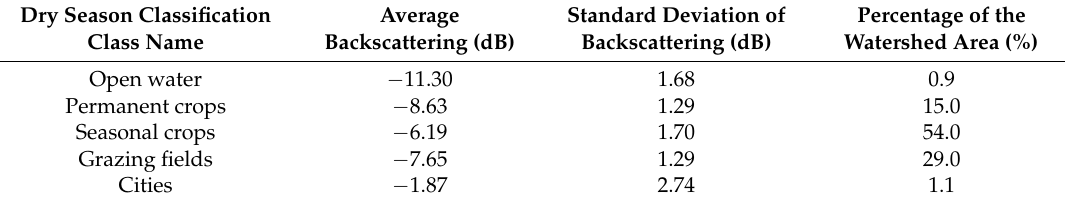
Table 2. Results of the k-nearest neighbors supervised classification performed on ENVISAT ASAR GM images acquired during the dry season (July–September) between 2005 and 2008. For each class, average backscattering (dB), associated standard deviation (dB), and percentage of the watershed area (%) are given.